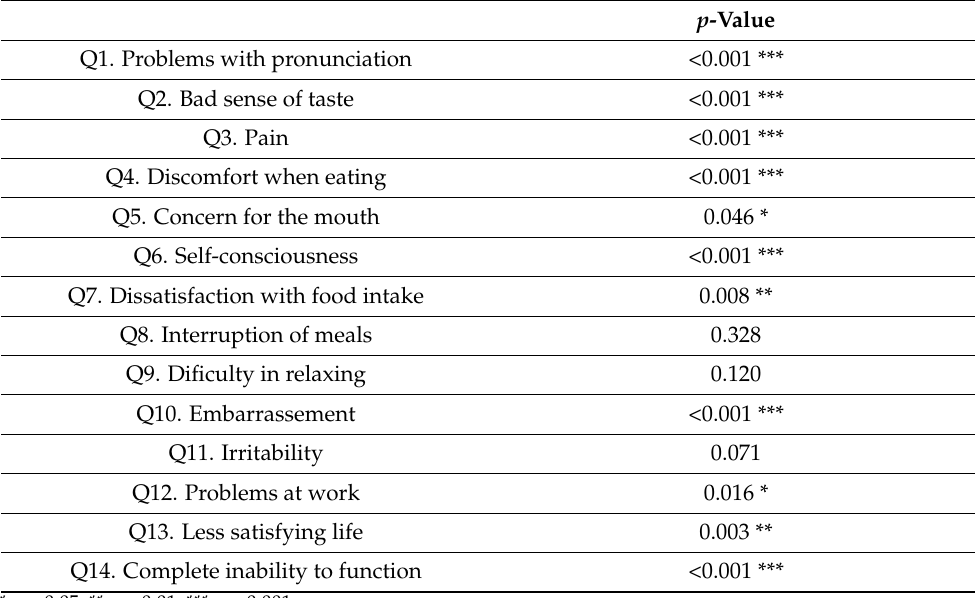
Table 1. Homogeneity of the groups of treatment according to total OHIP-14 scores in T0: Kruskal– Wallis test results.